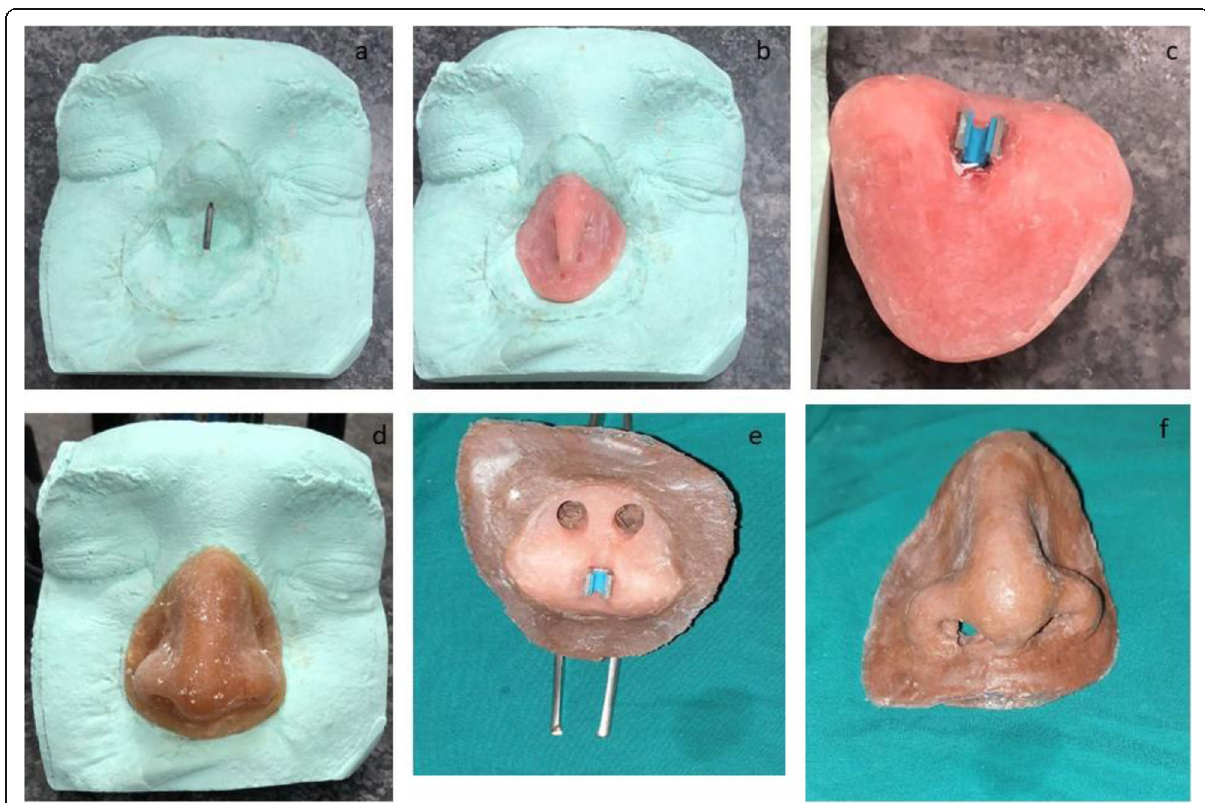
Fig. 9 A removable nasal epithesis with a custom made bar clip. a - f Steps of making the nasal epithesis. The clip was fabricated by doing casting of wax pattern over the body of the zygoma implant; then, it was cut in half. Retentive wings were also fabricated along the clip. The half-cut clip was fixed to the tissue surface of the nasal epithesis to be used as a clip over the body of zygoma as a